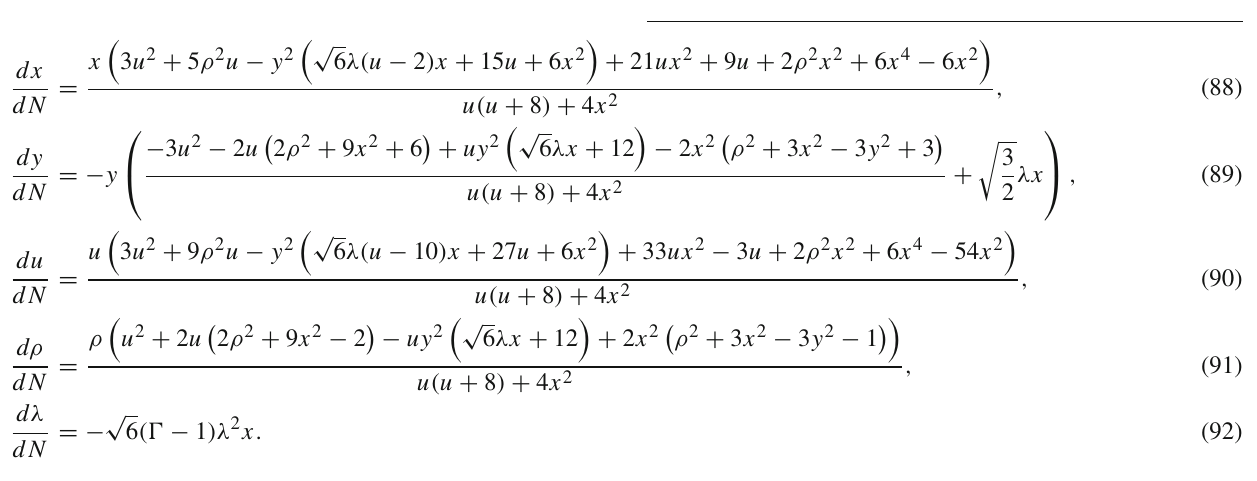
Fig. 6 Left phase portrait is plotted for the parametric values u = 0, ρ = 0 and λ = σ = 1 for right side 4